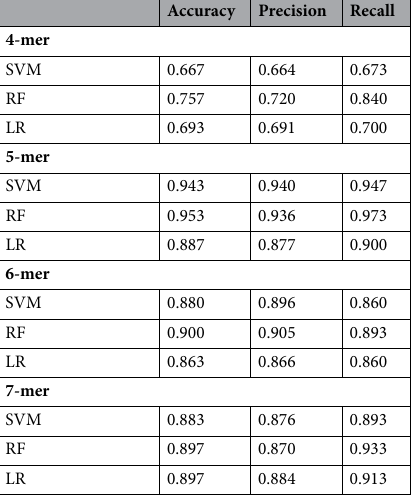
Table 2. The predictive scores of each prediction algorithm for identifying peptides with acid bile binding activity. SVF: support vector machine, RF: random forest, LR: logistic